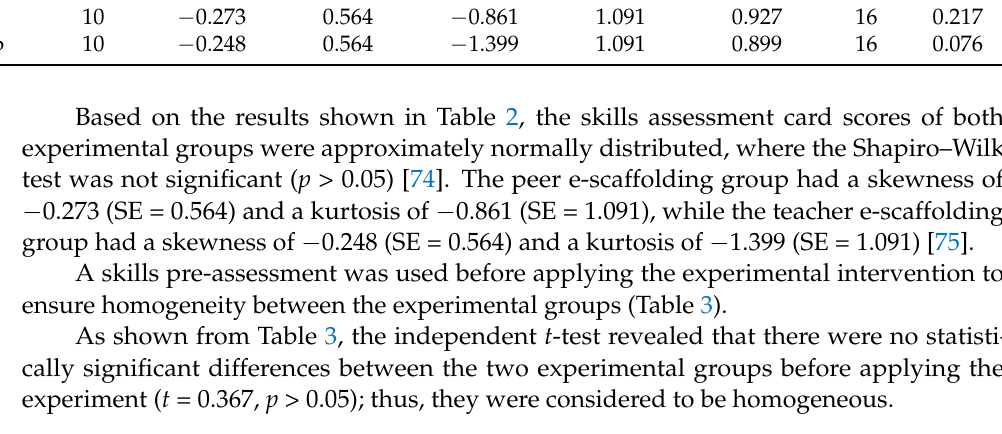
Figure 2. Example # 2 of students ’ virtual environments (deep ocean) .